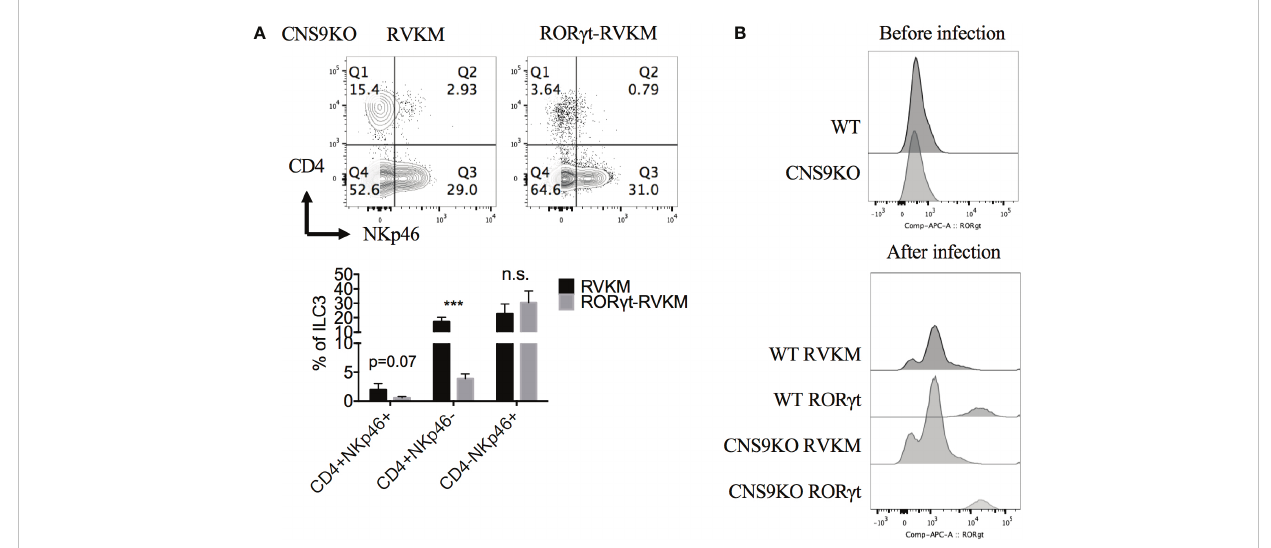
FIGURE 6 Reduced ROR g t expression after CNS9 de fi ciency are the cause of altered ILC3 subsets. RV-GFP control or ROR g t-expressing plasmids were transduced into CNS9-de fi cient BM cells by retro-virus infection. The infected GFP + cells were sorted and transferred into irradiated CD45.1 + mice introveneously. ILC3s from small intestine LPLs were gated as Live CD45 + CD3 - CD90 + ROR g t + cells. (A) Up: surface staining of CD4, NKp46 in ILC3s; down: statistic of the staining data (n=4 for RVKM group and n=3 for ROR g t -RVKM group). (B) ROR g t protein staining in WT or CNS9- de fi cient BM cells before (up) and after (down) retro-virus infection (after retro-virus infection, BM cells were pre-gated on live GFP + cells). The fl ow data shown are a representative of two independent experiments and the statistical analysis was performed by combining two experiments and presented as mean ± SD. Also see Figure S6. Statistical signi fi cance was calculated using unpaired Student ’ s t test and shown as ***p < 0.001 or n.s. (non-signi fi cant) p >